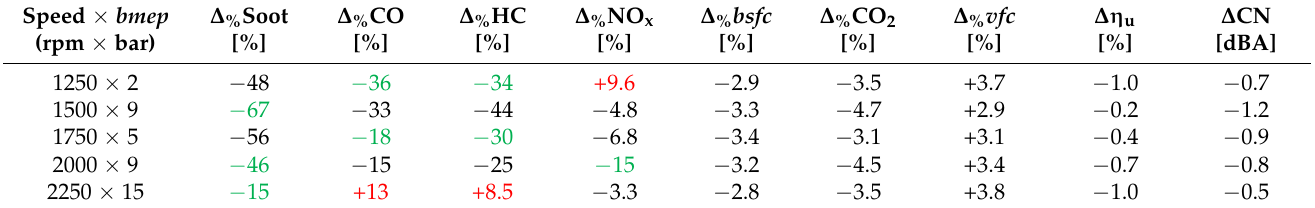
Table 3. Diesel vs. HVO comparison on 5 baseline calibration points (percentage